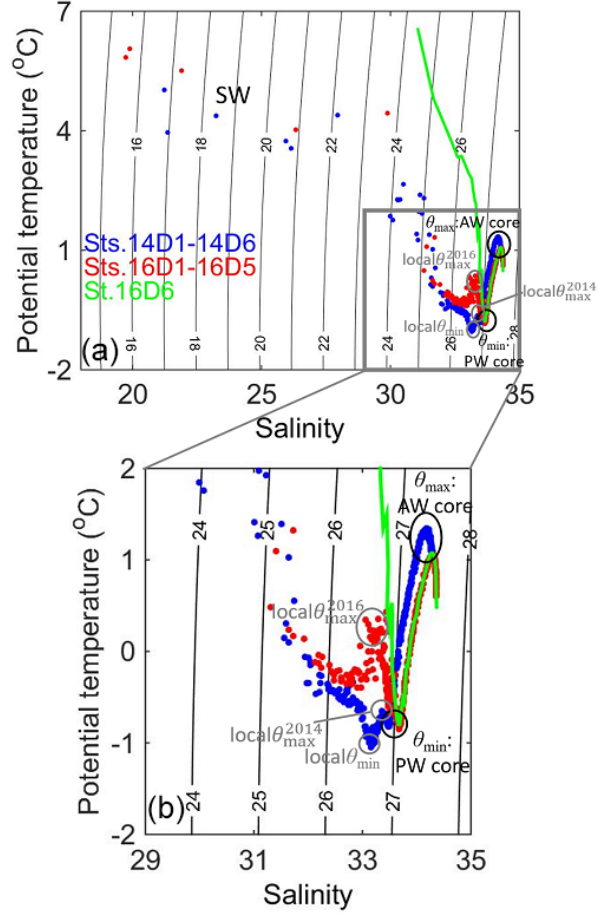
Figure 2. (a) Potential-temperature–salinity diagram for the data from 2014 and 2016. Dots are shown at 5m intervals. The color of the markers corresponds to the sampling sites as indicated in Fig. 1b (blue in 2014, red at stations 16D1–16D5, and green at sta- tion 16D6). The potential densities are shown by the black isopy- cnal contours. The gray box indicates the domain shown in Fig. 7. (b) shows the enlarged region indicated by the gray box in (a)